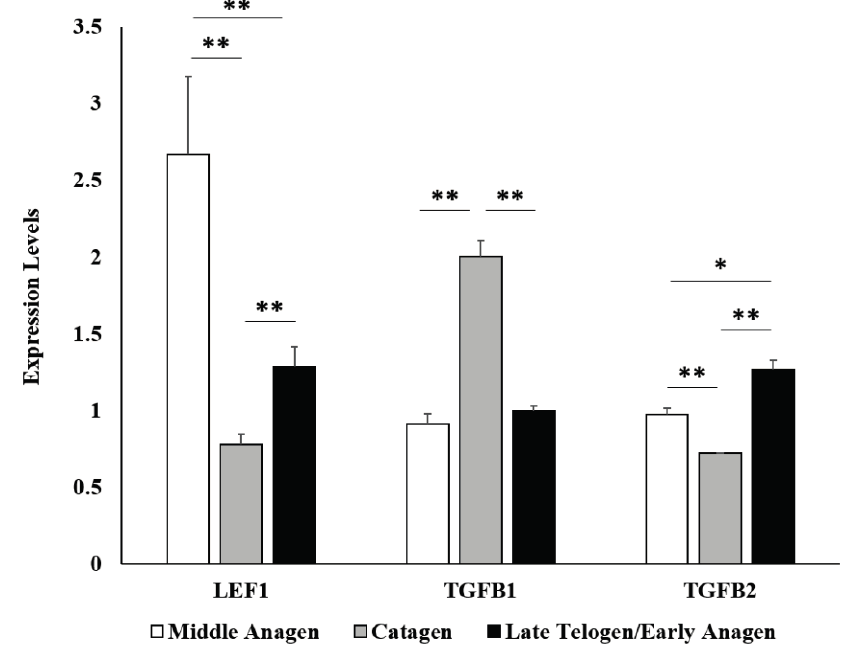
Figure 2. Validation of the expression levels of LEF1 , TGFB1 and TGFB2 marker genes by qPCR. The expression levels of LEF1 , TGFB1 and TGFB2 genes were checked by qPCR, to confirm that our samples were collected from the right phases. Previous studies showed that the expression level of LEF1 in hair follicles is higher in anagen compared with the catagen and telogen phases [15], whereas the expression level of TGFB1 is upregulated in catagen [16], and the expression level of TGFB2 is upregulated in late telogen/early anagen [17]. Both the qPCR results and sequencing data showed that the expression patterns of these three genes were consistent with the expected phases (** p < 0.01,* p <